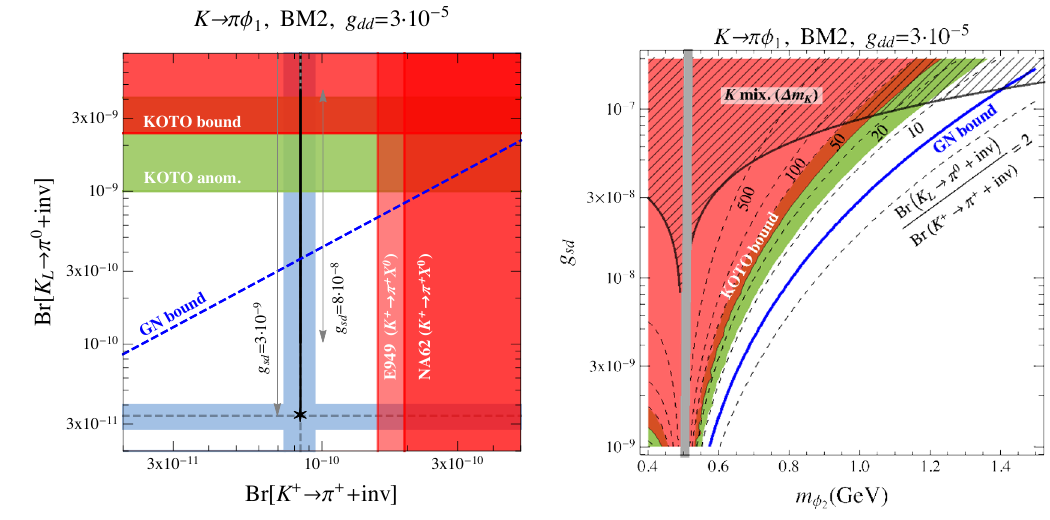
Figure 6 . The preferred parameter space for Model 1, BM2. Color coding is the same as